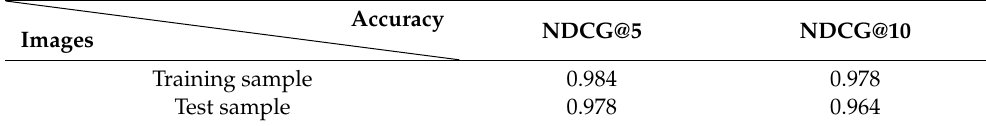
Table 2. Optimal weights of the three feature distances for precipitation image.